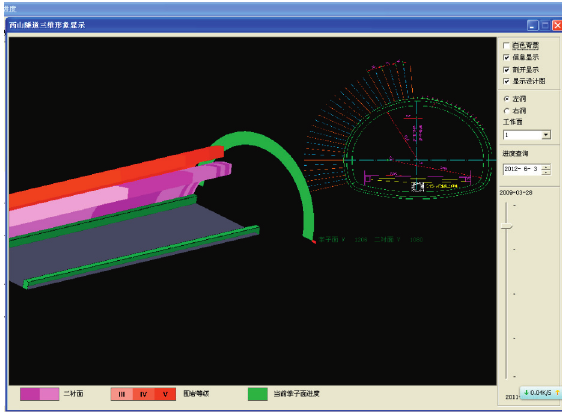
Figure 11: Three-dimensional tunnel model